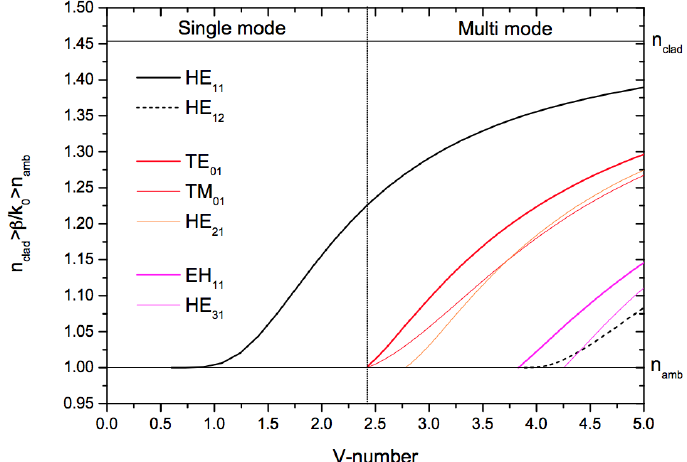
Figure 2. A plot of the effective index of refraction, , against V-number for an optical fiber with cladding and core refractive indices as 1.4537 and 1.000, respectively.  represents the propagation constant. The vertical line indicates the boundary between single- and multimode guidance in the fiber (V =